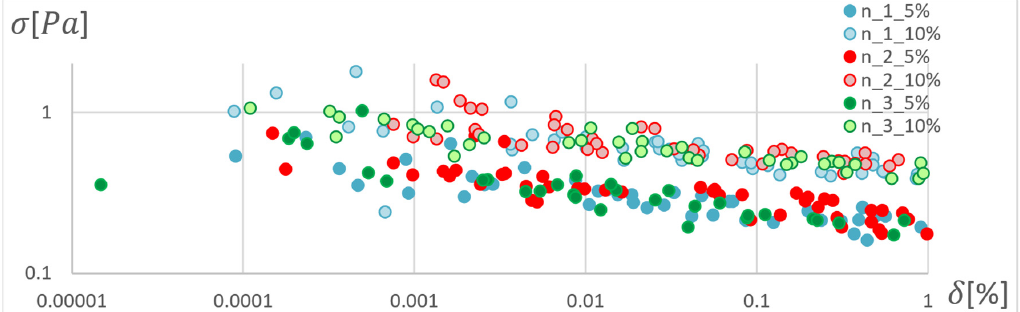
Figure 11. Pareto fronts for all networks trained using the GDM algorithm, in the zone of highest accuracy.